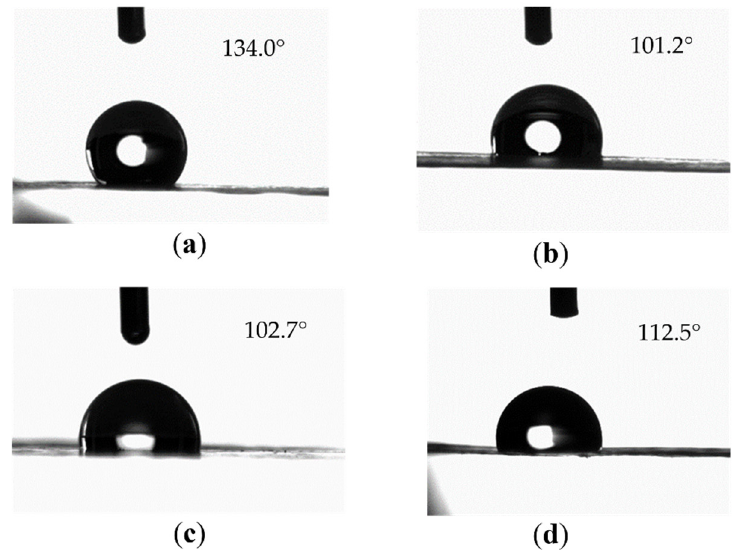
Figure 9. Water contact angles of ( a ) fluorinated paper (Fluo); ( b ) paper coated with PHBV with PEG 20% (PHBVpeg20); ( c ) polyethylene-coated paper (Poli); ( d ) paper coated with PCL with PEG 20% (PCLpeg20).